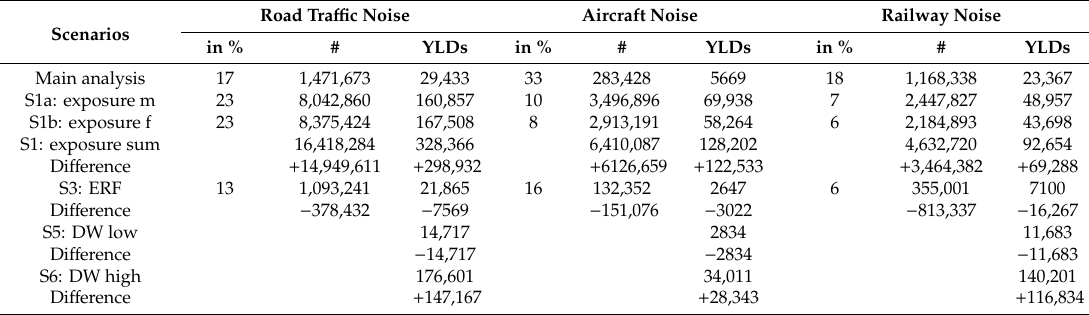
Table 11. Sensitivity analysis of the burden of disease due to annoyance attributable to tra ffi c noise in Germany, 2016.